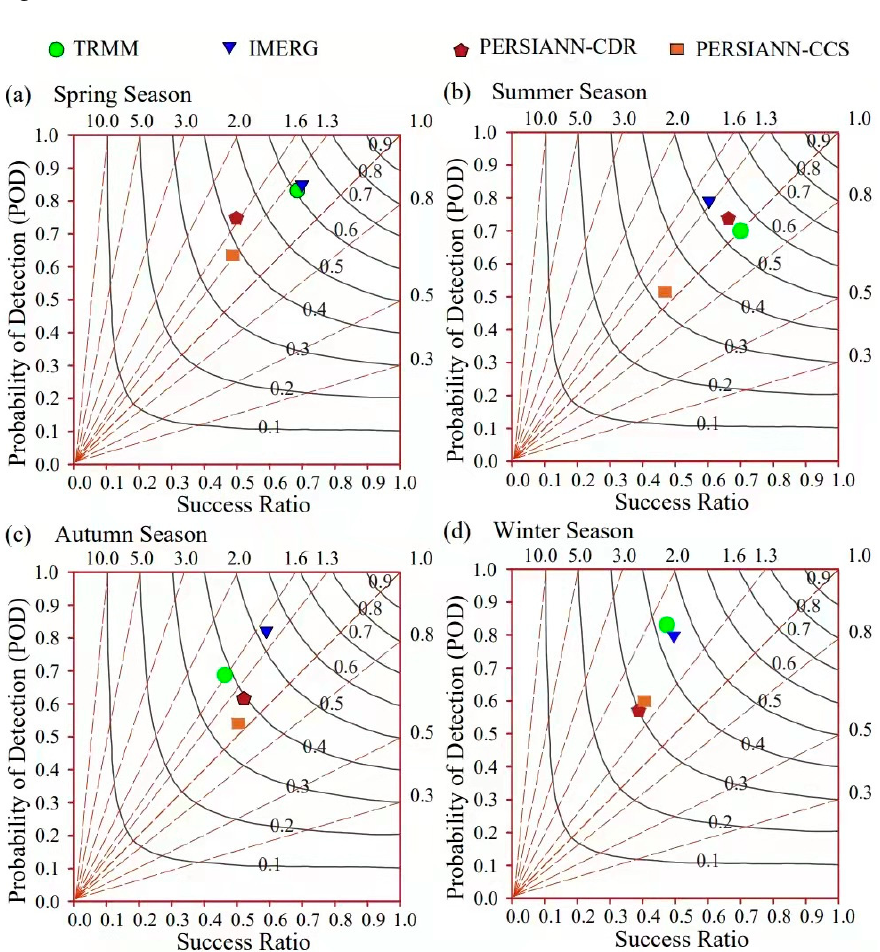
Figure 18. Seasonal performance of all SBPD.